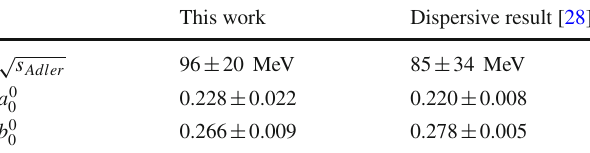
Table 6 Adler zero and threshold parameters. The latter in customary m π = 1 units. They are almost indistinguishable for solutions I, II